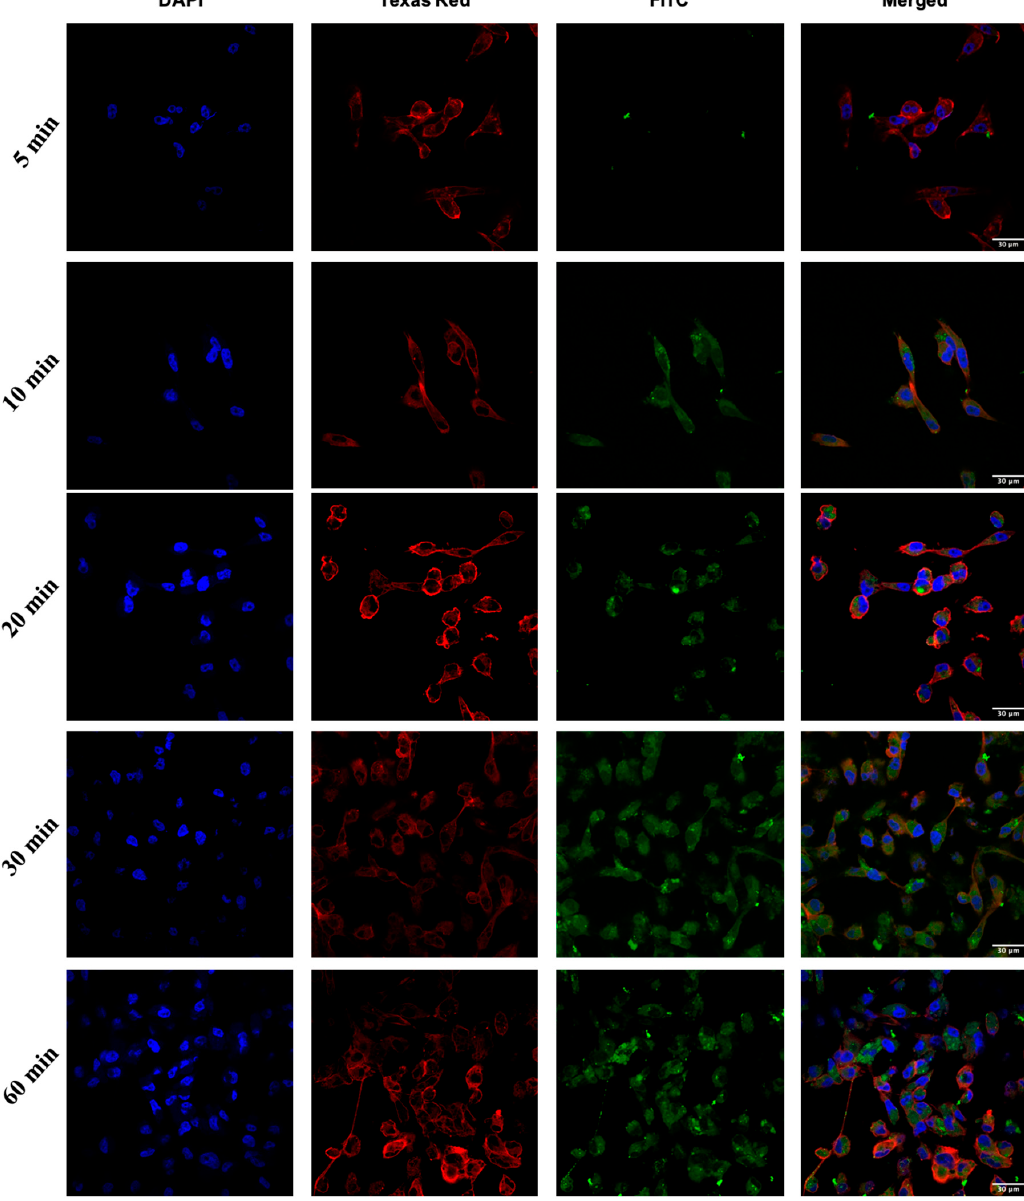
Figure 7. Confocal microscopy images of MDA-MB-231 cells incubated with GFP (50 nM) + [WR] 9 (4 µM) mixture at di ff erent time points (5–60 min). The blue, red, and green channels visualize DAPI (used to stain the nucleus), Texas Red (used to stain the cell membrane), and GFP,